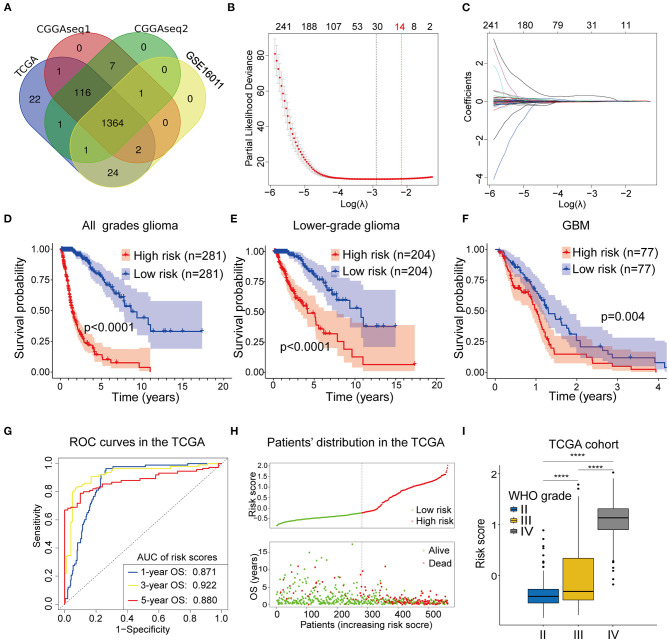
(A) The Venn plot showing the 1364 RBP genes identified in all the four cohorts. (B,C) Least absolute shrinkage and selection operator (Lasso) regression was performed to calculate (B) the minimum criteria and (C) coefficients. (D–F) The RBP-signature stratifies (D) glioma patients, (E) LGGs, and (F) GBMs into two subgroups with significantly different clinical outcomes. (G) Receiver operating characteristic (ROC) curves showing the 1-, 3-, and 5-year OS predictive efficiency of the RBP-signature. (H) The patient distribution plot showing that patients with higher risk scores are associated with shorter OS. (I) The box plot indicating that WHO grades are positively associated with risk scores.